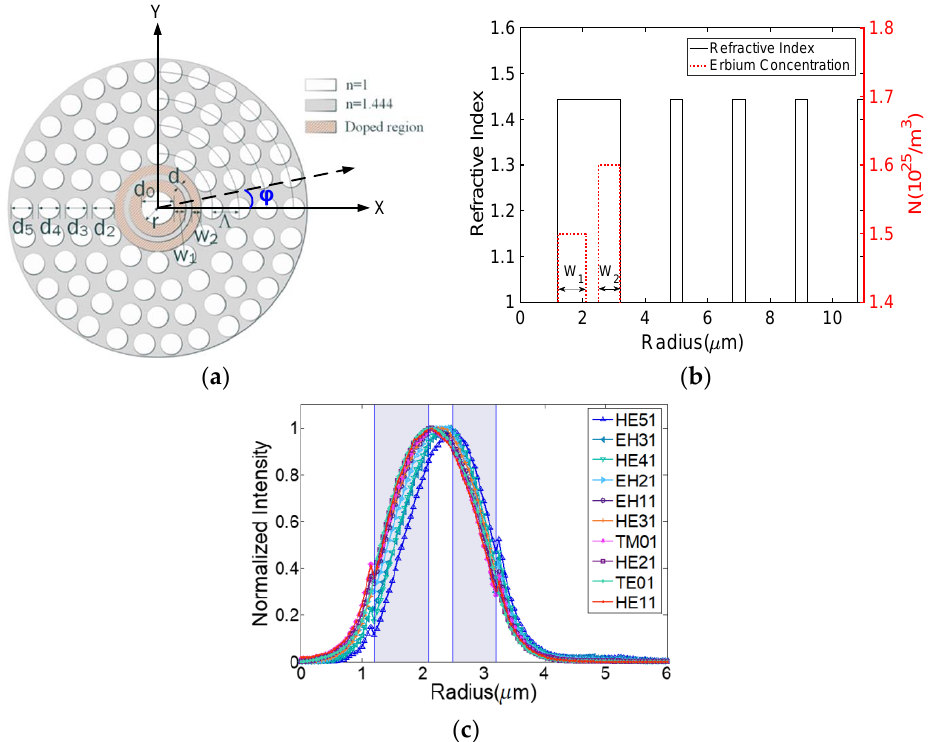
Figure 2. ( a ) Schematic of a cross-section and the Erbium-doped region of the circular photonic crystal fiber (C-PCF); ( b ) the refractive index and Erbium concentration profile of the fiber; ( c ) normalized intensity profile of the modes in the C-PCF.